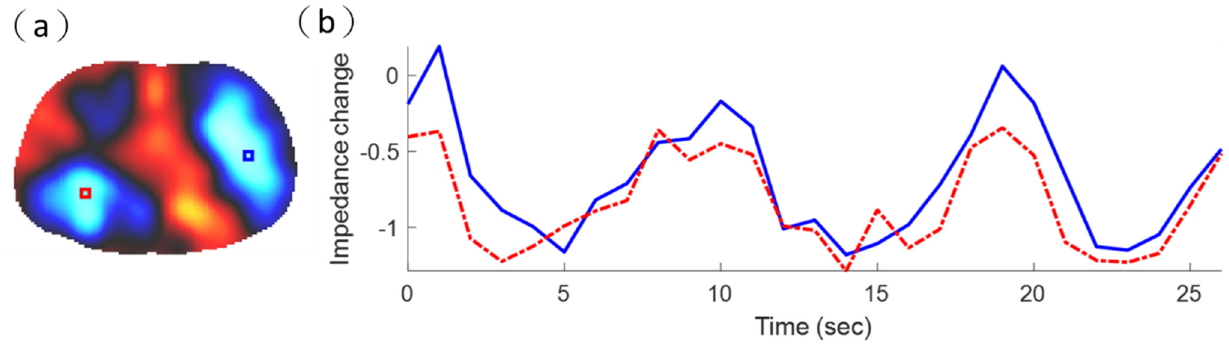
Figure 10. The reconstructed electrical impedance tomography (EIT) image obtained using commercial electrocardiogram electrodes. ( a ) EIT imaging of lung ventilation. ( b ) Two-pixel waveforms in the left lung (red) and right lung (blue).